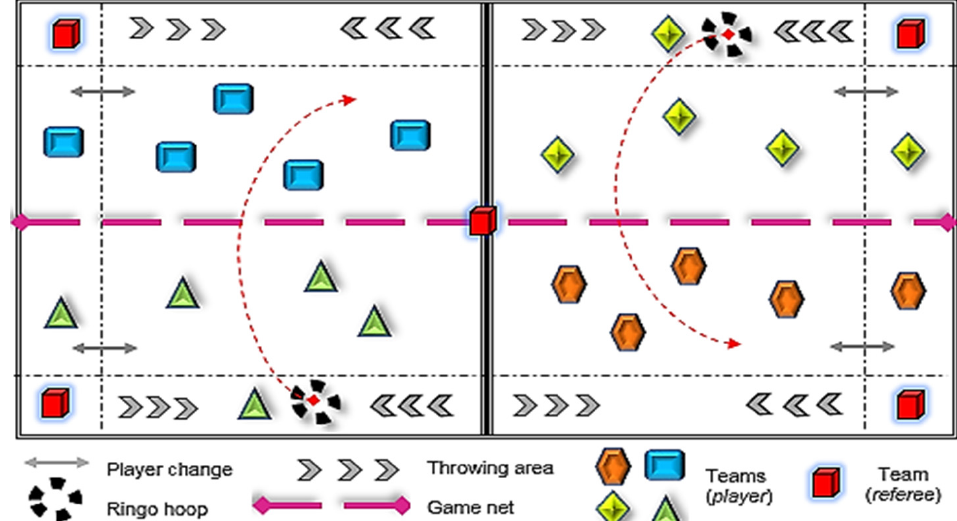
Figure 3. Ringo (Polish) sport practice session (source: Luna, P.).